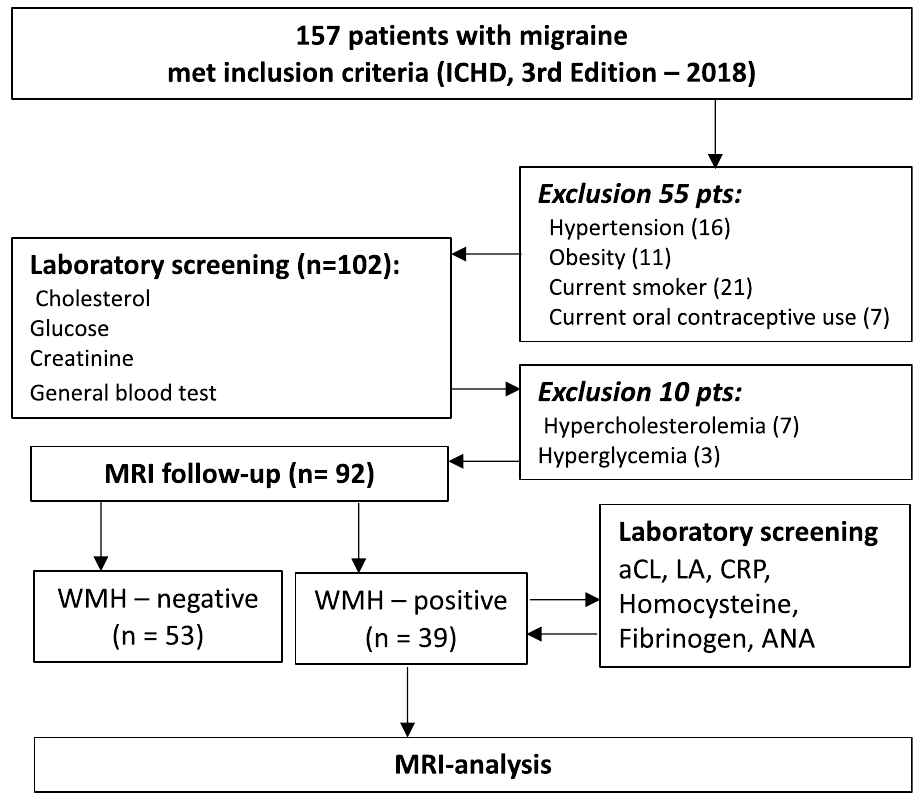
Figure 1. Flow chart of included and excluded subjects. WMH White matter hyperintensities, aCL Anticardiolipin antibodies, LA Lupus anticoagulant, CRP C-reactive protein, ANA Antinuclear